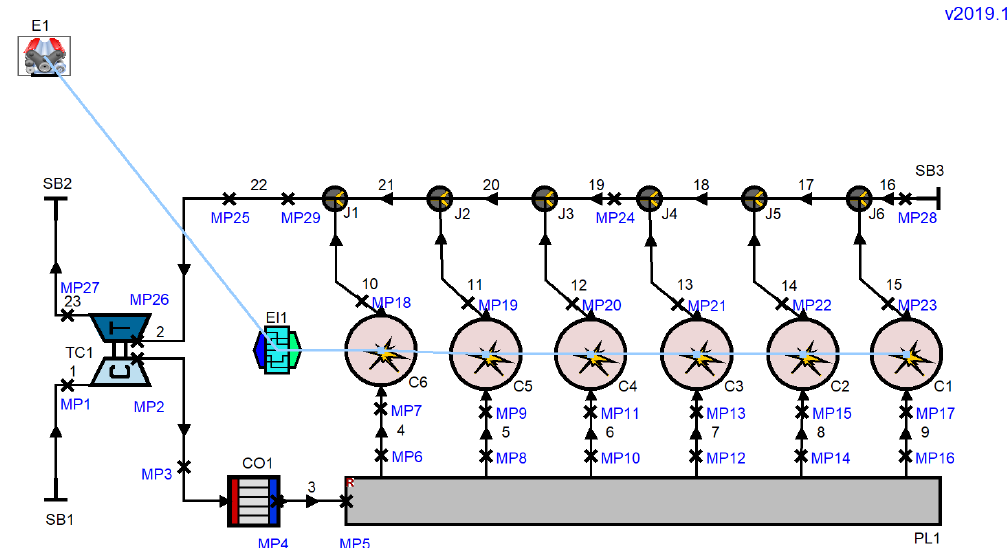
Figure 2. AVL BOOST model for a four-stroke marine diesel engine.